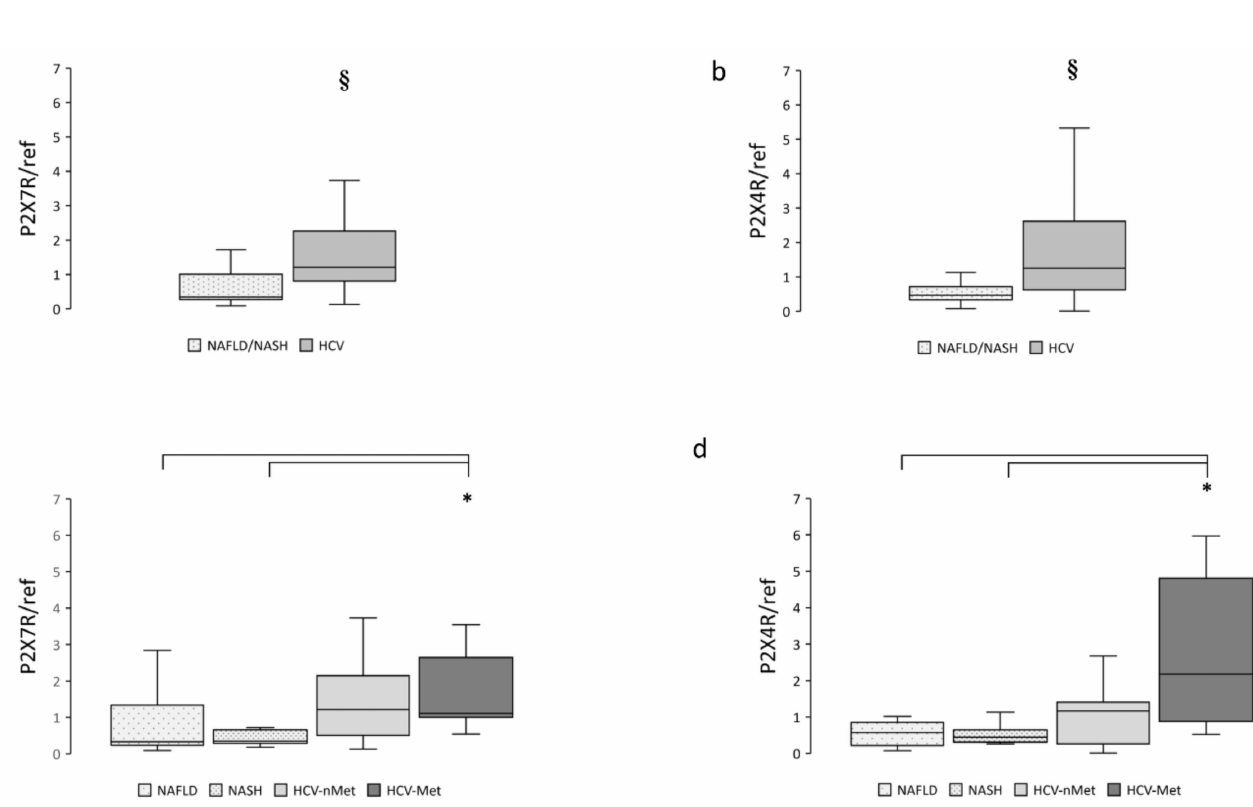
Figure 1. Hepatic P2X7R and P2X4R gene expression in the main study groups ( a , b ) and the four subgroups ( c , d ). Data are normalized to GAPDH expression. § p < 0.001, * p <